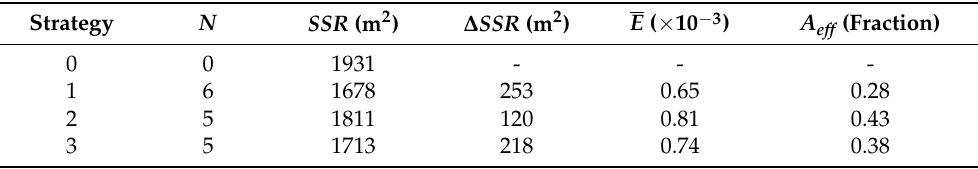
Table 1. Strategy wise pilot point performance